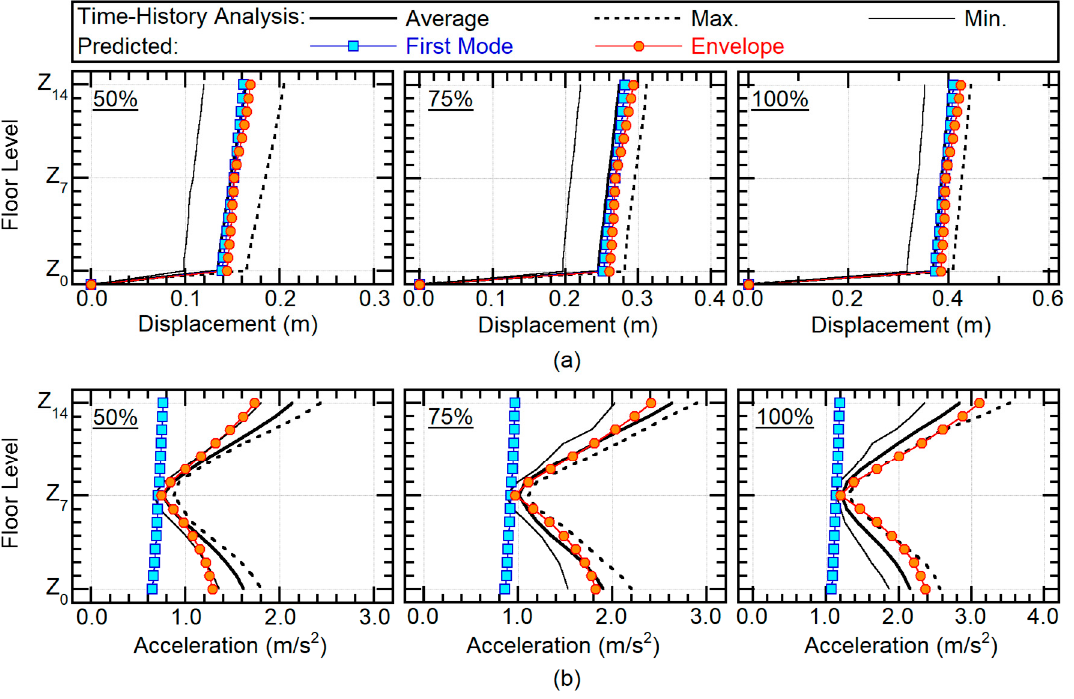
Figure 12. Comparison of maximum floor response (Art-S series): ( a ) relative displacement; ( b ) absolute